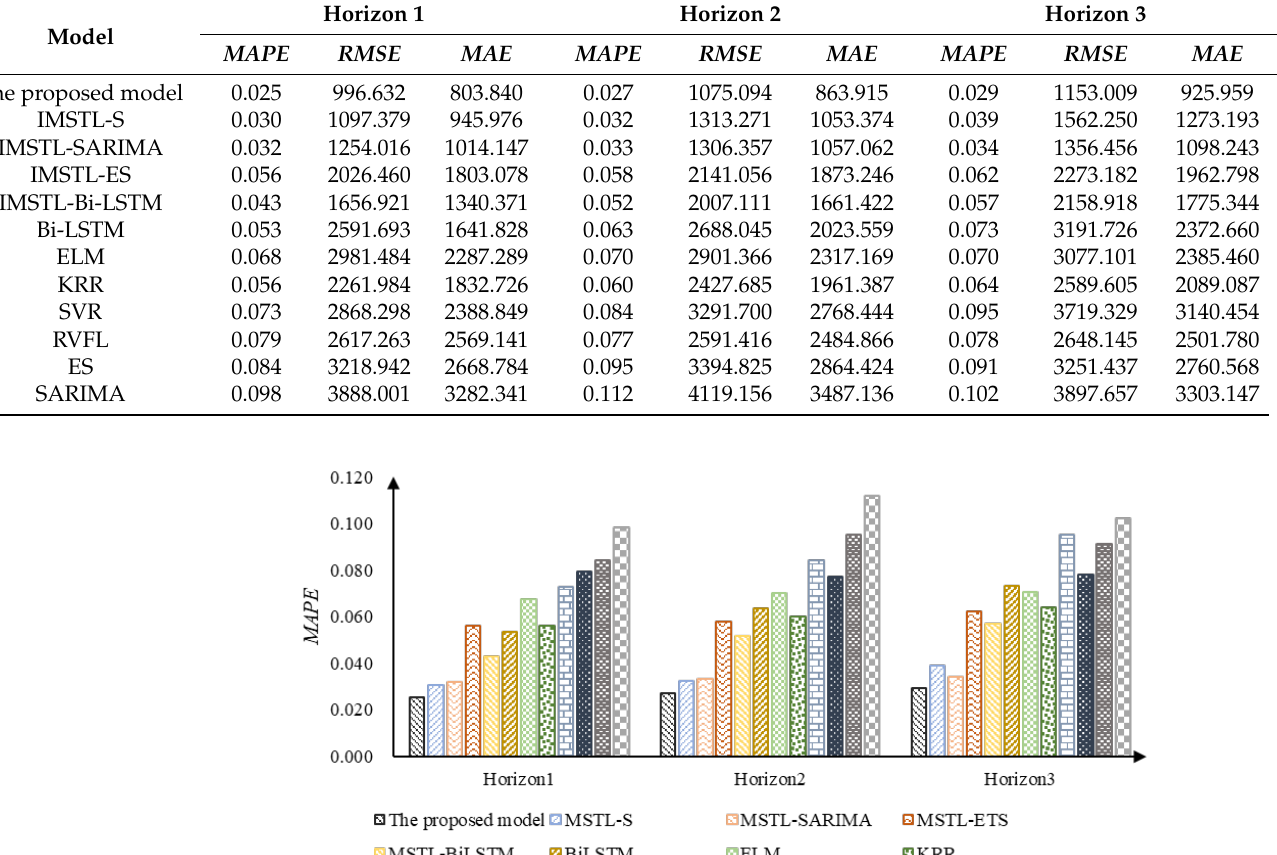
Table 6. Prediction performance of different models.